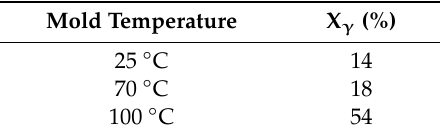
Figure 10. X-ray di ff raction patterns of neat PP in comparison with the 3%-MWCNT nanocomposites Figure 10. X-ray diffraction patterns of neat PP in comparison with the 3%-MWCNT nanocomposites manufactured at the three di ff erent mold temperature. manufactured at the three different mold temperature. Table 1. Fraction of PP γ -phase in 3%-MWCNT Table 1. Fraction of PP γ -phase in 3%-MWCNT nanocomposites.